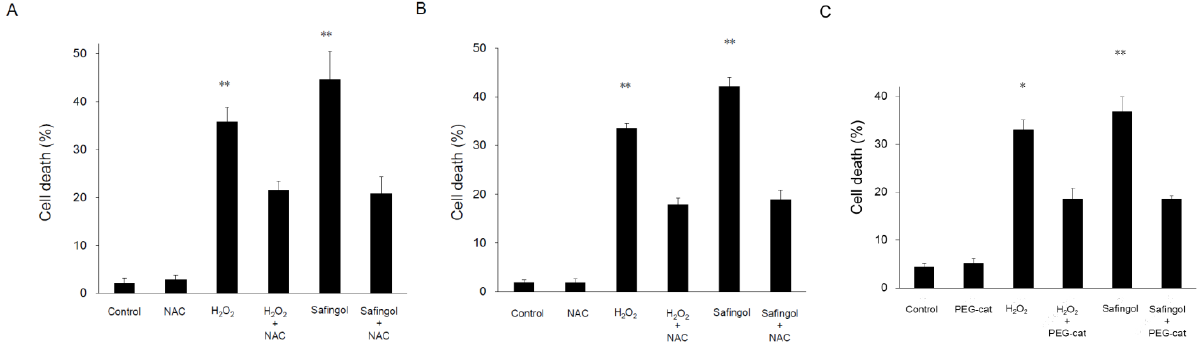
Figure 2. Induction of cell death by H O and safingol. SAS ( A ) and HSC-3 ( B ) cells were 2 2 treated with 100 µM H O or 15 µM safingol alone. Alternatively, they were treated with 2 2 H O or safingol in the presence of the ROS scavenger NAC for 12 h. SAS cells were 2 2 treated with 100 µM H O or 15 µM safingol alone. Alternatively, they were pretreated 2 2 with 500U PEG catalase (PEG-cat) for 2 h and then they were treated with H safingol for 12 h ( C ). Thereafter, the cells were stained with trypan blue. The percentages of dead cells were calculated. The data represent the mean ± SD of three determinations.